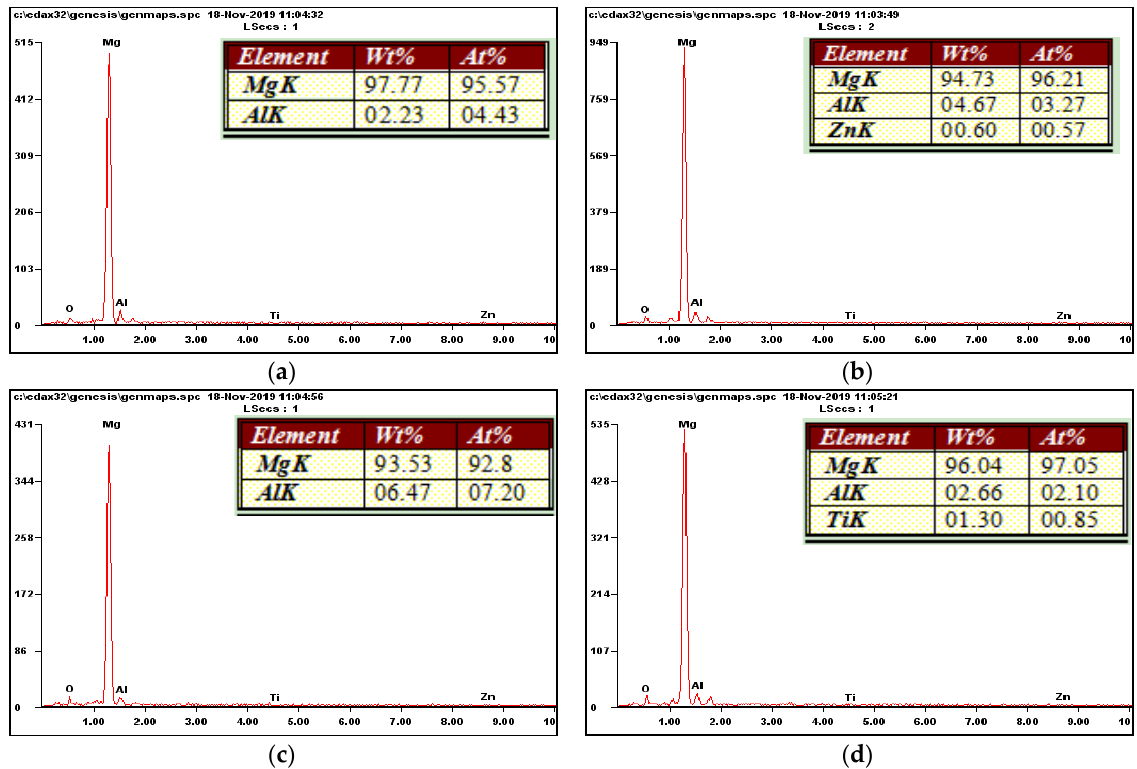
Figure 6. EDS analysis results of weld metal when applying magnetic field. ( a ) Site A; ( b ) Site B; ( c ) Site C; ( d ) Site D.